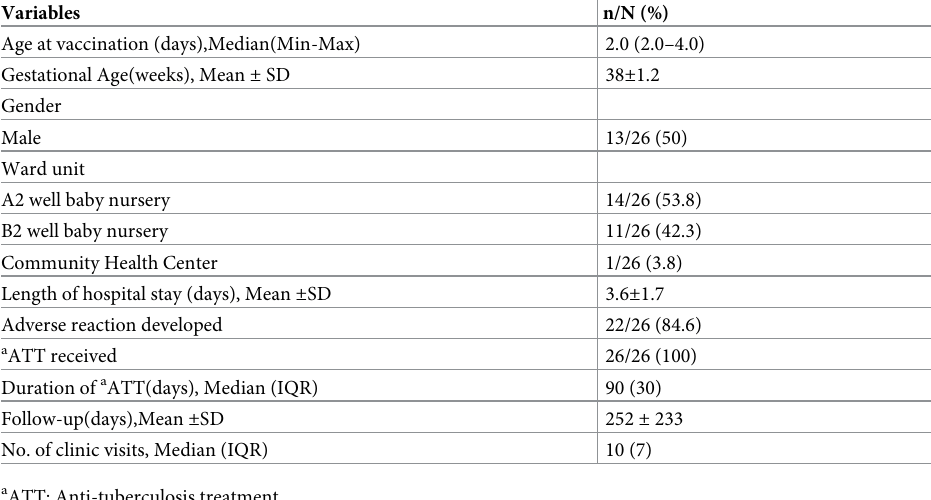
Table 1. Demographics of newborns who had received high dose BCG